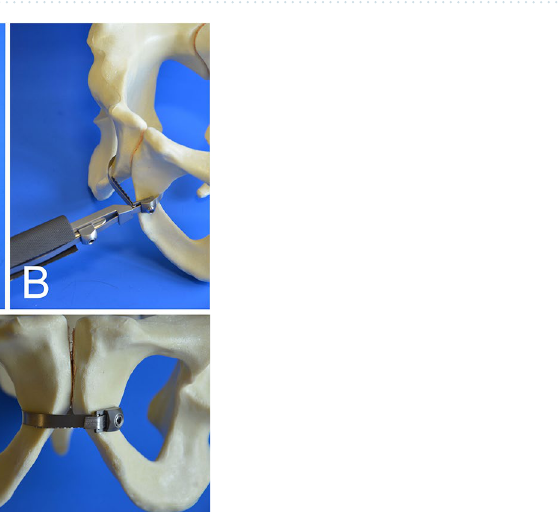
Figure 1. Different groups tested. ( A ) Stabilization with a four-hole 3.5-mm stainless steel plate. ( B ) Trans- obturator wire using a 1.7-mm cable system. ( C ) Trans-obturator fixation using a broad titan band. Ten specimens were tested in each group.